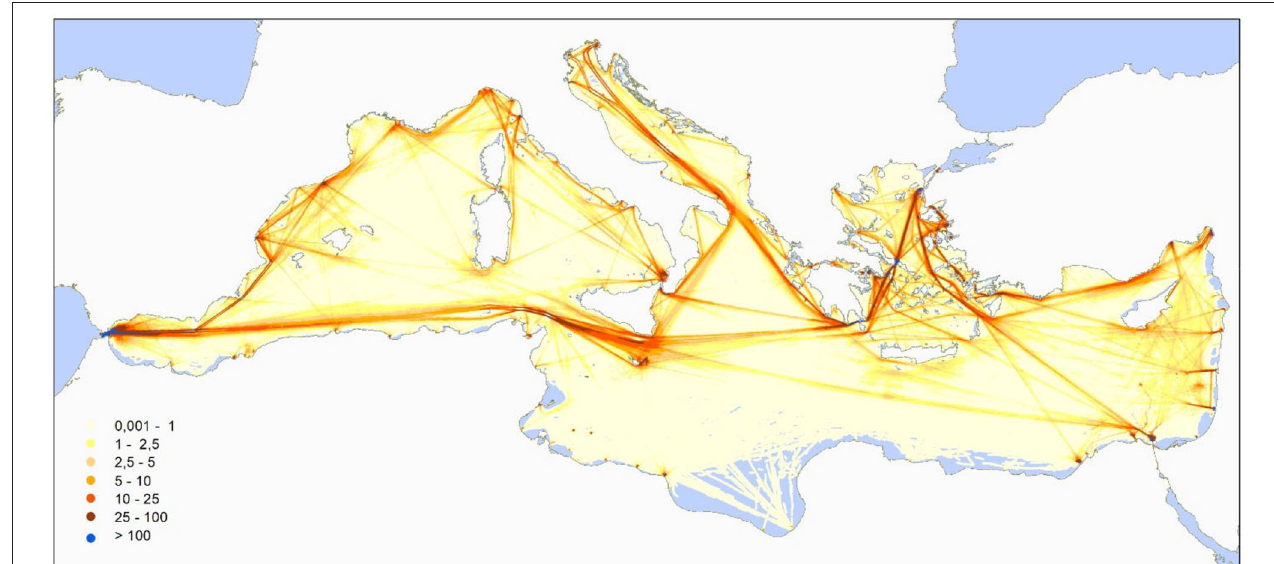
FIGURE 2 | Maritime traffic density (hours/year) for cargo exploitable for slaked lime discharge.